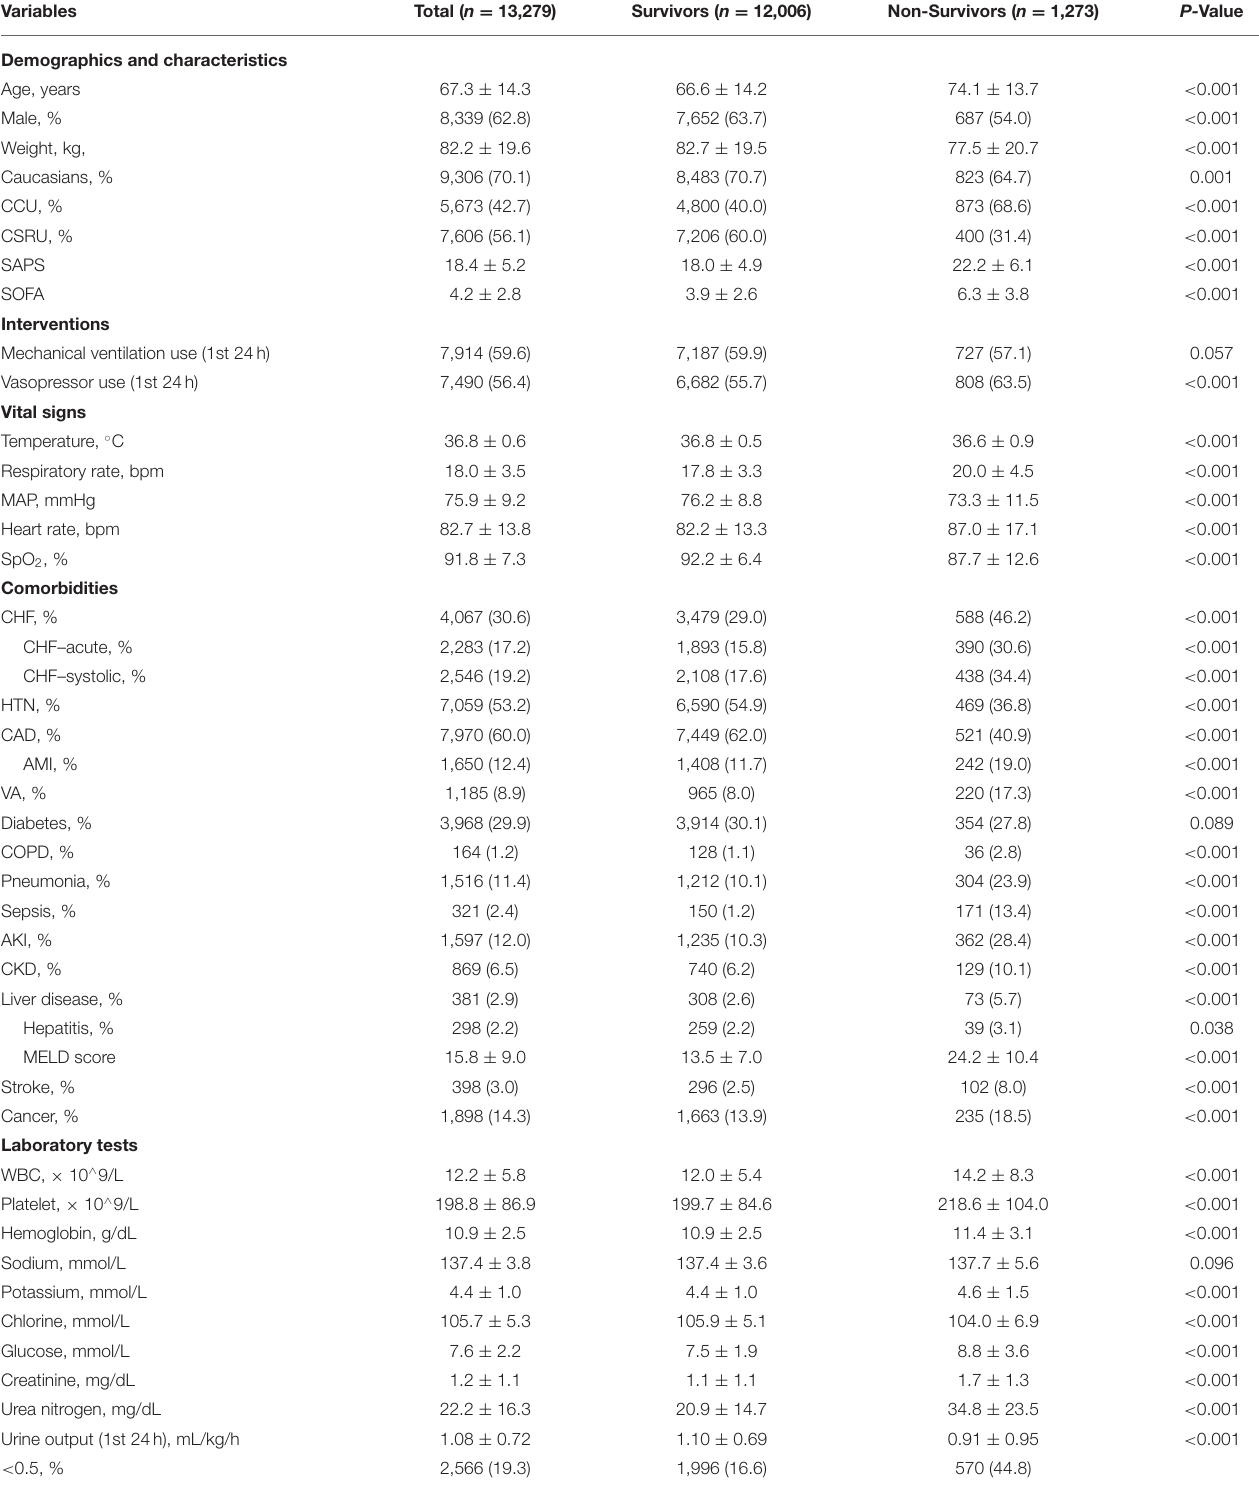
TABLE 1 | Comparisons of demographics between survivors and